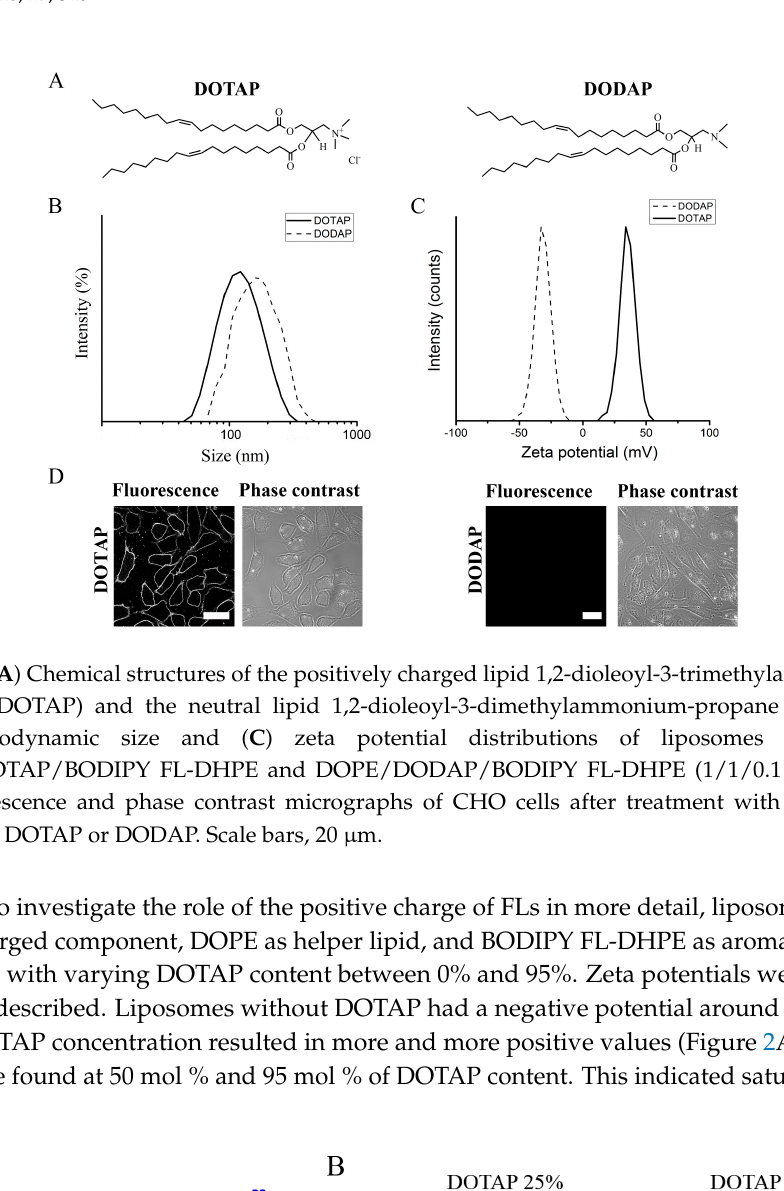
Figure 3. ( A ) Fluorescence micrographs of CHO cells after treatment with liposomes containing DC Cholesterol, DOEPC, MVL5 or DOTMA as cationic lipid, DOPE as neutral component and BODIPY FL-DHPE as fluorescent component (1/1/0.1 mol/mol). Scale bars, 20 µm. ( B ) Favoured membrane curvature of the reported cationic lipids. ( C ) Chemical structures of DC Cholesterol, DOEPC, MVL5 and DOTMA used as cationic lipids in FLs. Putative molecular shapes are indicated by red lines.